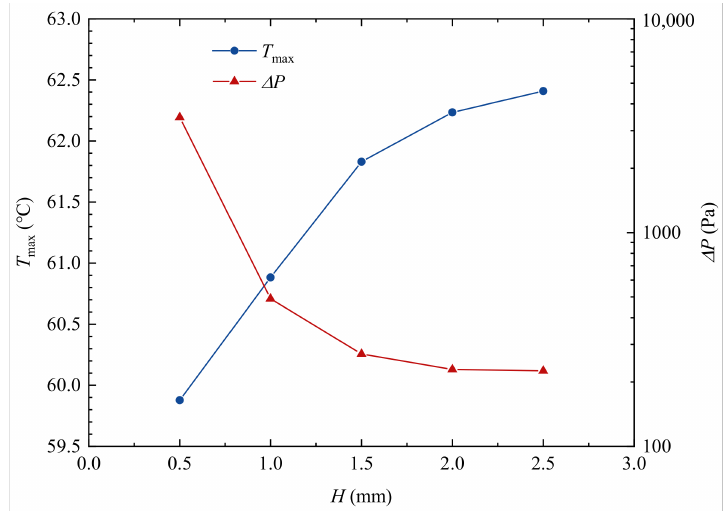
Figure 5. The relationship between T max , ∆ P and H when d = 2